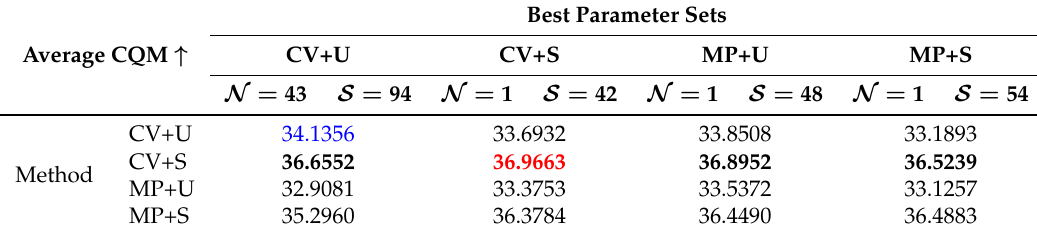
Table 3. Average performance of LaBGen-P-Semantic, measured by the CQM, with CV+U, CV+S, MP+U and MP+S. Each column provides the best set of parameters N and S for a given combination of methods and estimators. For a given set of parameters, each row provides the average CQM score of a given method. The best average CQM score reached with a given set of parameters is in bold and with the CV (resp. MP) method is in blue (resp.